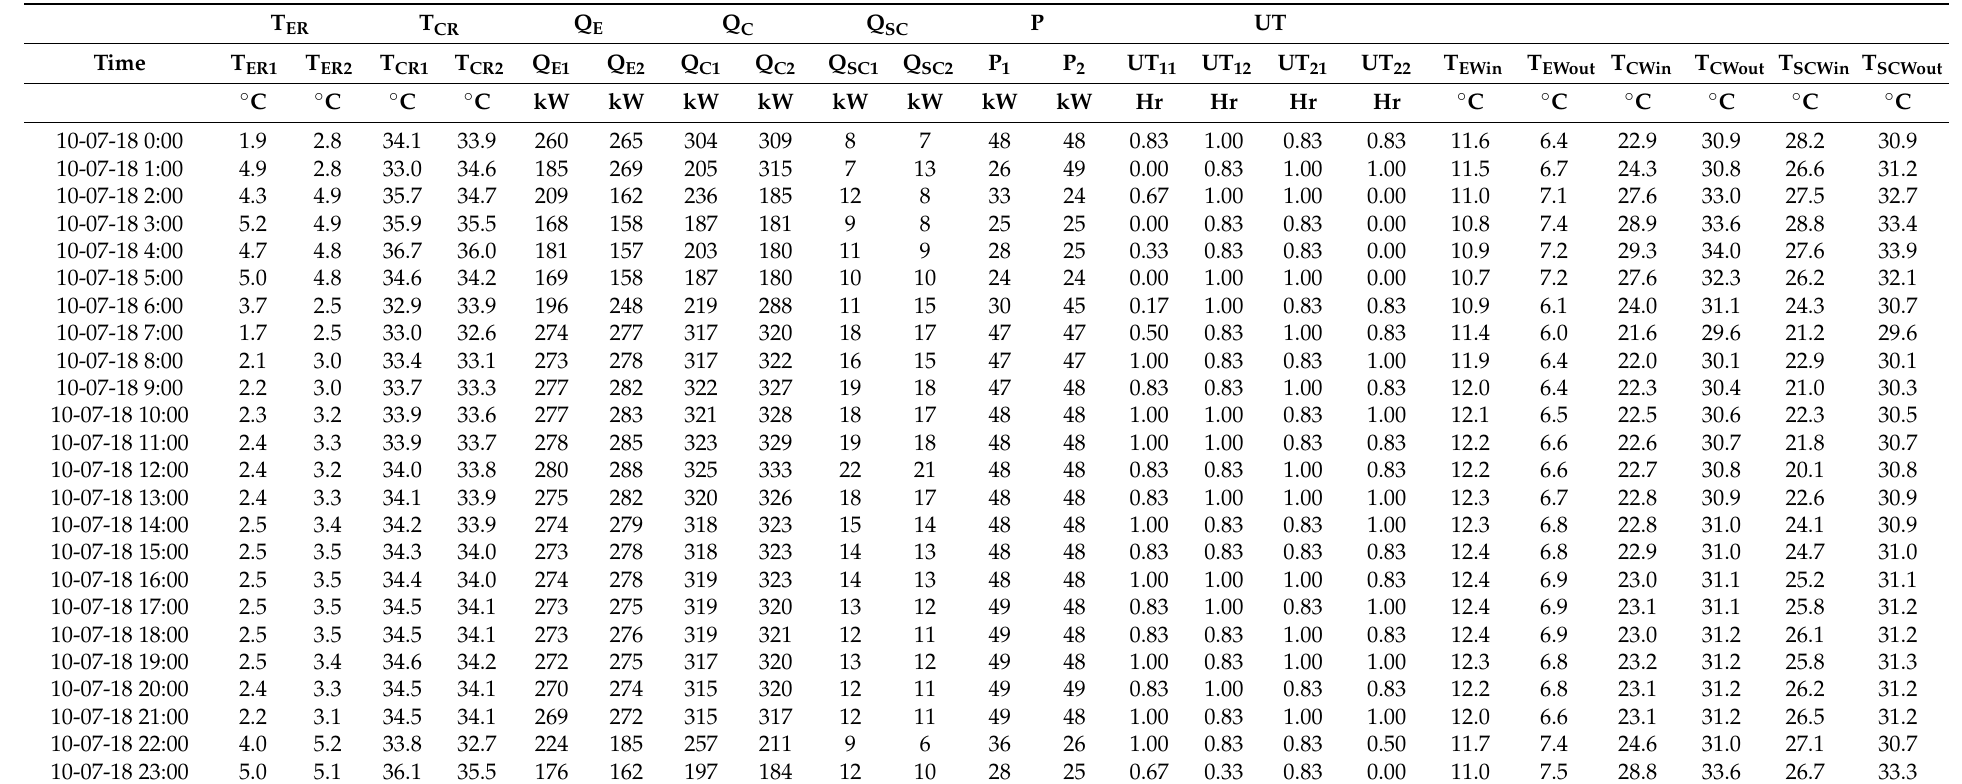
Table A4. Sample data from HP1 for a typical summer